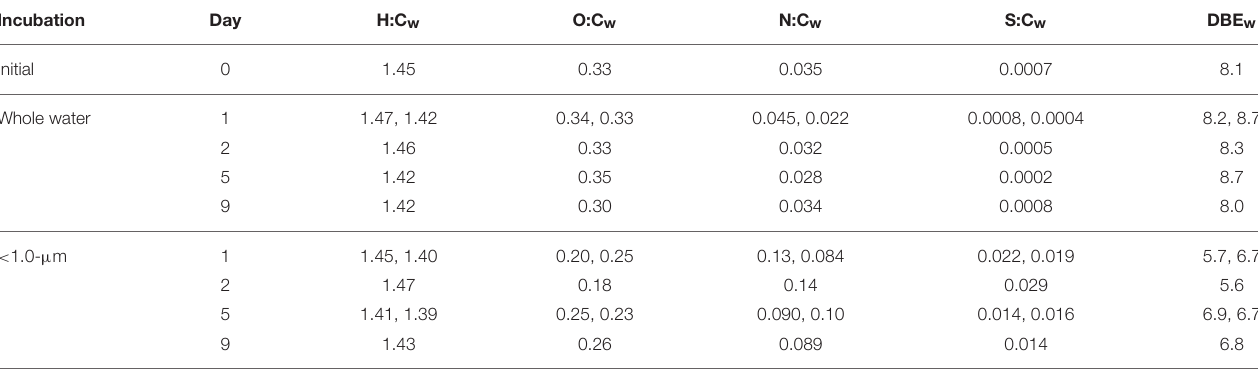
TABLE 1 | Elemental ratios for all samples, calculated as magnitude-averaged values (Sleighter and Hatcher, 2008) for m/z values with assigned elemental formulas. Incubation